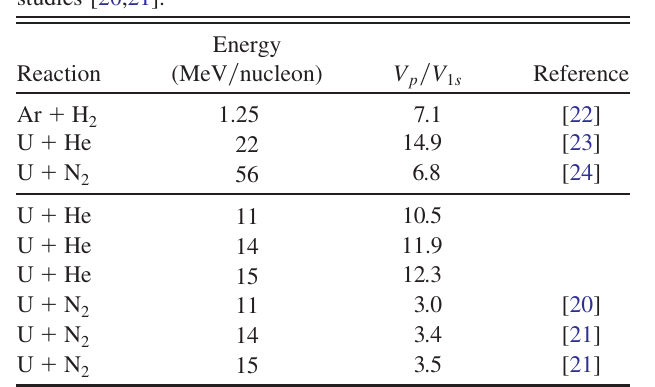
TABLE II. Atomic collision systems for which enhancement of equilibrium charge is observed in a low- Z target region. The is the relative projectile velocity with parameter of V p =V 1 s respect to K-shell electrons. The lower part of the table lists the reactions for which equilibrium charge-state measurements were carried out by our group in this study and in our previous studies [20,21].